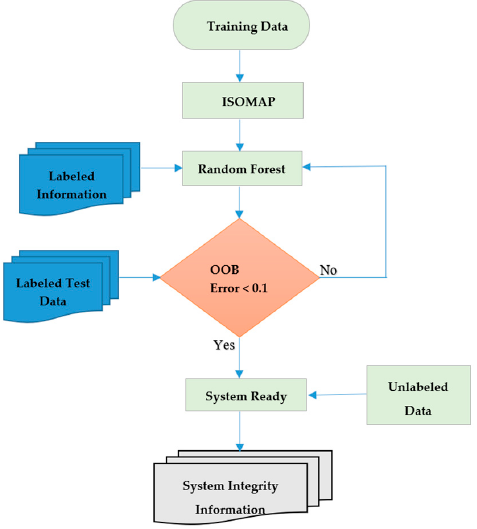
Figure 4. Flowchart of the proposed